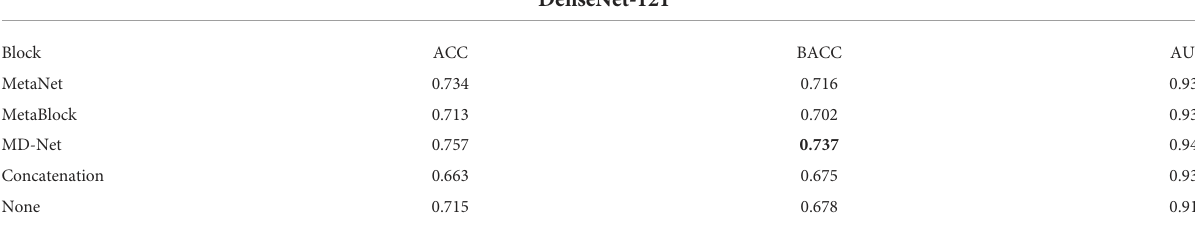
TABLE 6 Compare the performance of DenseNet-121 network fusing different modules on the PAD-UFes-20 dataset. HIGHEST AVERAGE BACC FOR EACH MODEL.